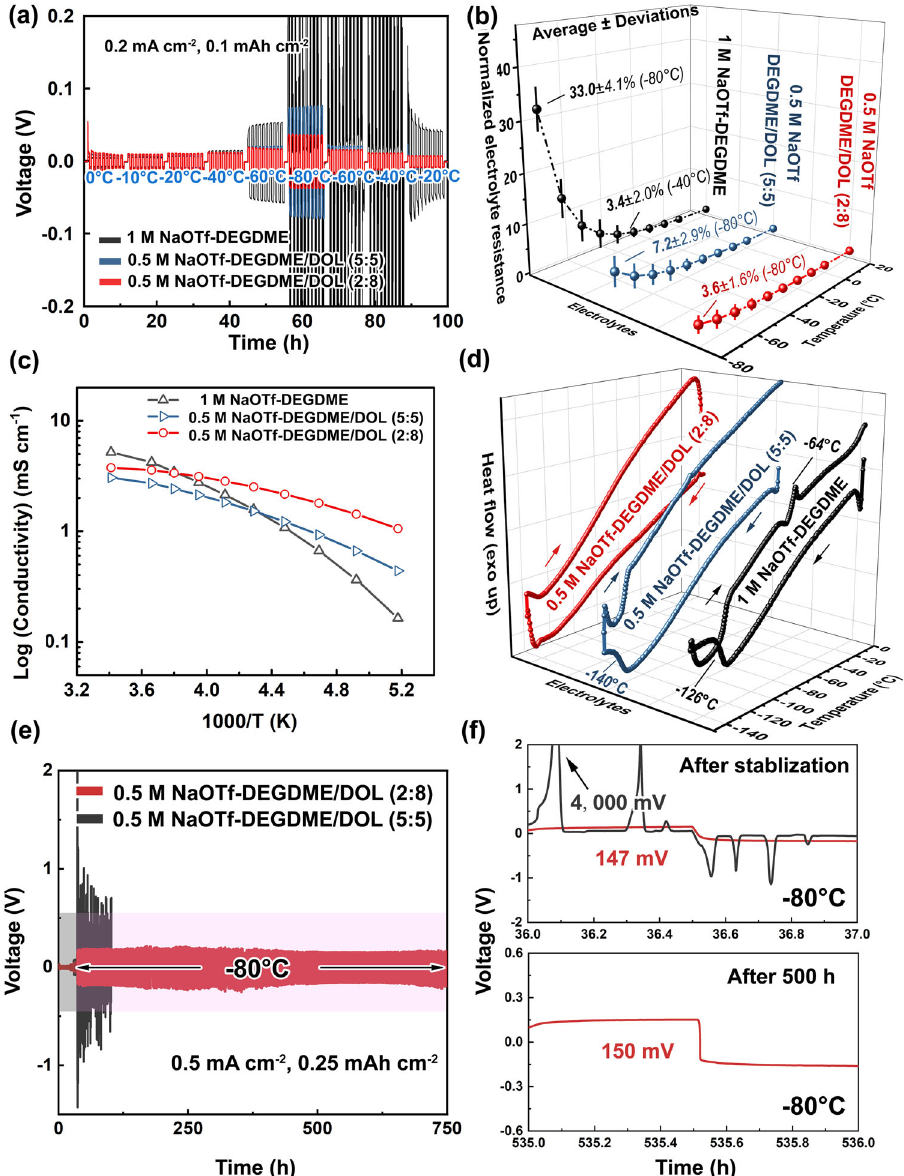
Fig. 4 | Electrochemical and physicochemical characterizations of different NaOTf-based electrolyte solutions at various temperatures. a Temperature- dependent galvanostatic cycling of Na||Na symmetric cells at 0.2mAcm − 2 and 0.1mAh cm − 2 . b Change in the resistance of the electrolyte solutions in the temperature range between +20°C and − 80°C. The resistance values at dif- ferent temperatures are normalized to those at +20°C (the value of each elec- trolyte solution at+20°Cis given as1). The averages/deviationswerecalculated